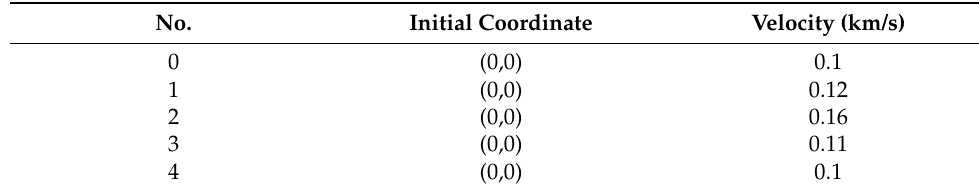
Table 6. The attributes of UAVs in Example